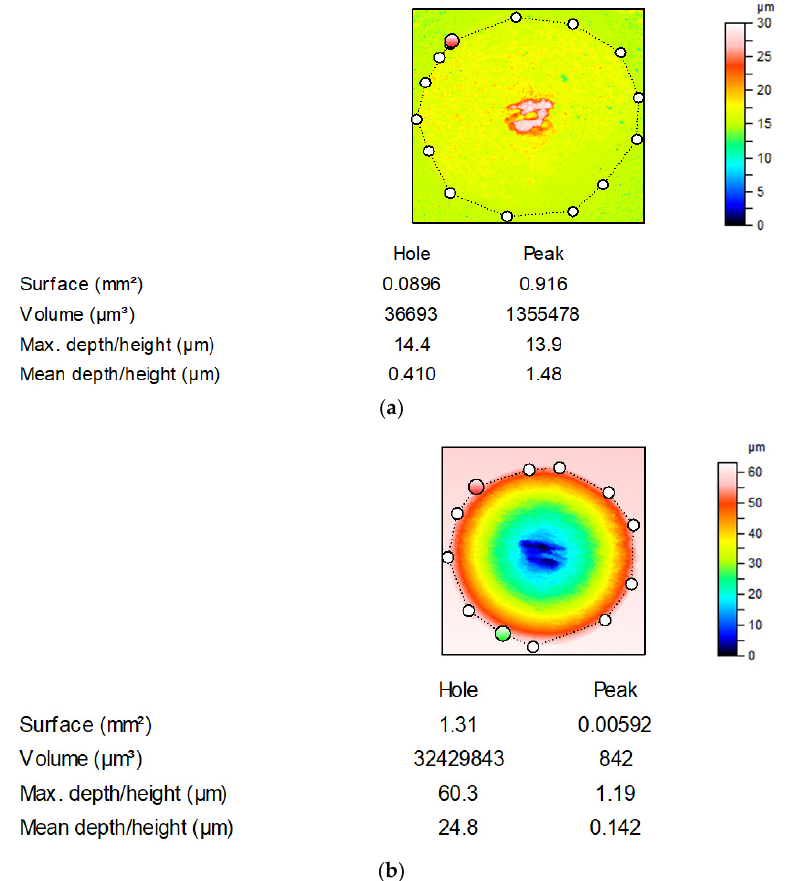
Figure 3. Example of the estimation of the total wear volume of the tribological system: wear of ball: (V ball − ) = 36,693 µm 3 , (V ball +) = 1,355,478 µm 3 , V ball = − 1,318,785 µm 3 ( a ); wear of disc: (V disc − ) = 32,429,843 µm 3 , (V disc +) = 842 µm 3 , V disc = 32,429,001 µm 3 ( b ); total volumetric wear: V total = 31,110,216 µm 3 .